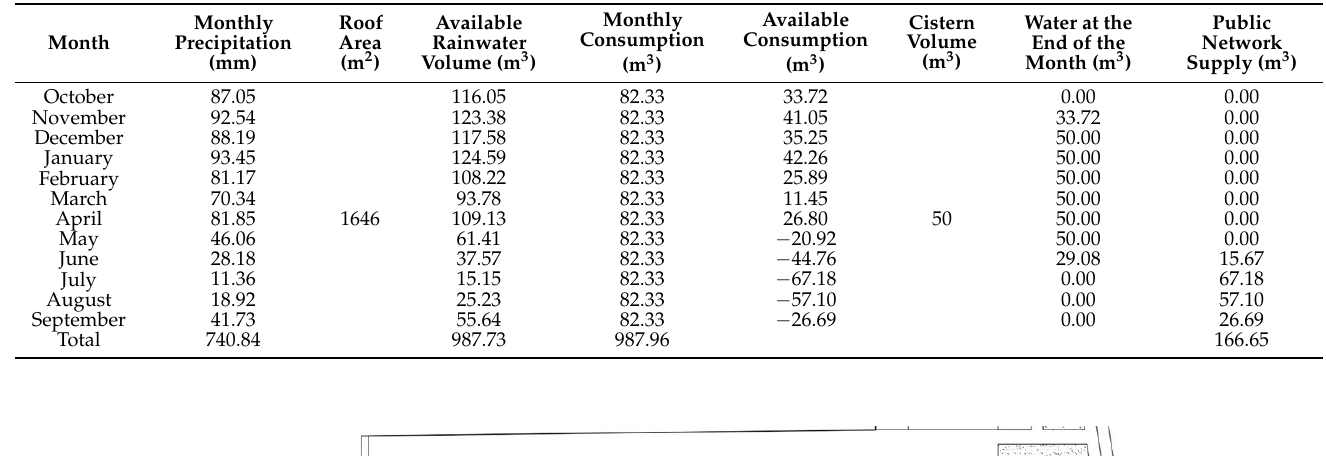
Table 5. RWHS cistern sizing simulation.